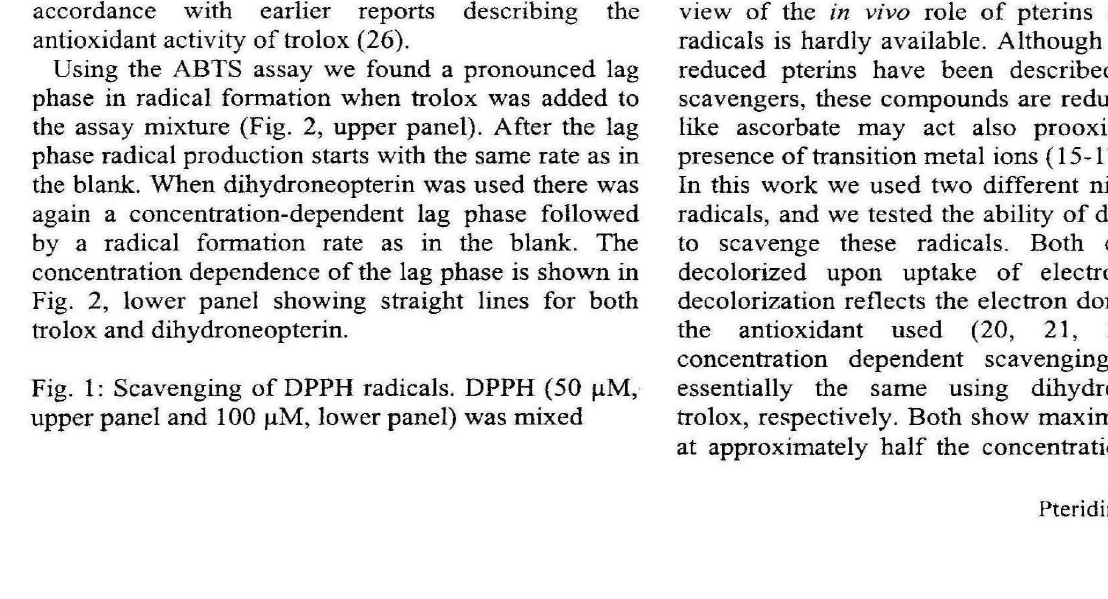
Fig. 1: Scavenging of DPPH radicals. DPPH (50 f.lM, upper panel and 100 !-1M, lower panel) was